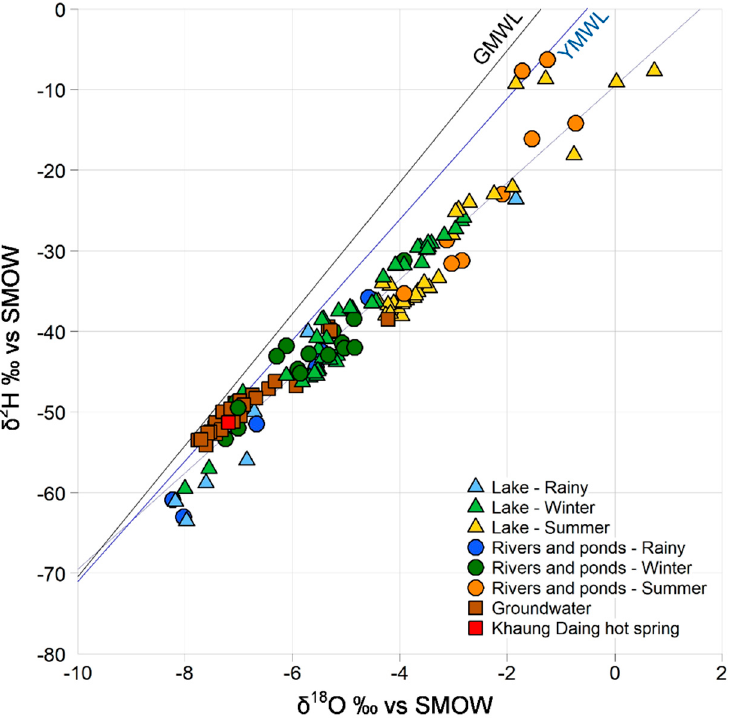
Figure 5. Seasonal variation of the isotopic composition of lake waters, compared to the Global Meteoric Water Line (GMWL, [44]) and Yangon precipitation waters (YMWL, [45]).